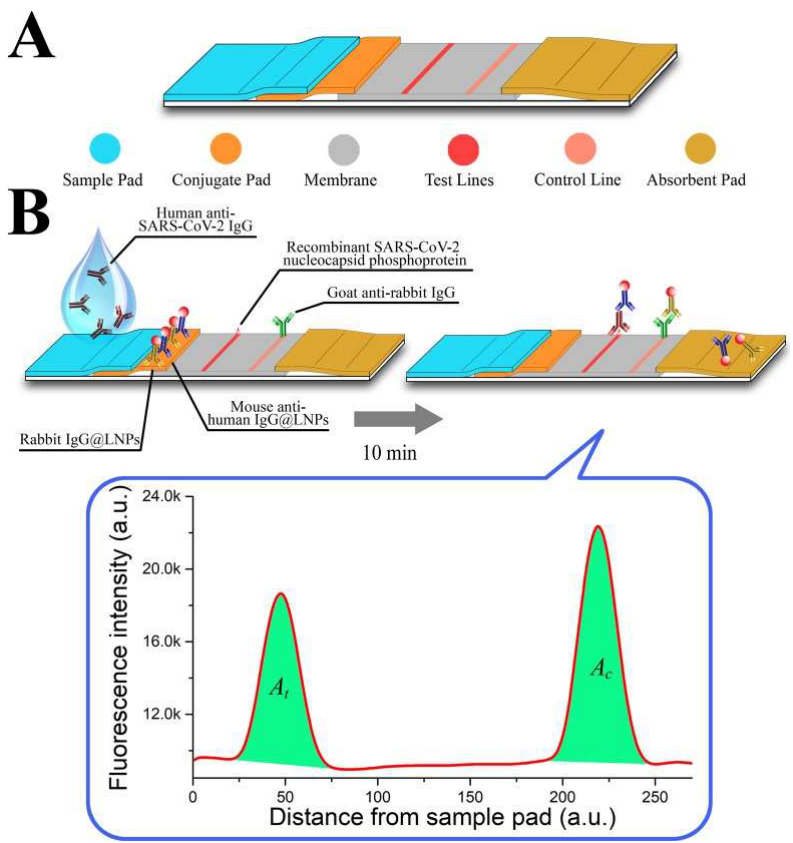
Figure 5. ( A ) An illustration of the developed lateral flow strip; ( B ) An illustration of the assay, incorporating the LNPs as fluorescent signalers [92]. Immunoassays revolving around AuNPs were also developed for the detection of SARS-CoV-2. Wen et al. [71] described the creation of a point-of-care LFIA used to detect the IgG antibodies against SARS-CoV-2. The strip was compromised of an immobilized SARS-CoV-2 nucleocapsid protein on the strip’s surface and anti-human IgG coupled with colloidal AuNPs. Colloidal AuNPs were mainly chosen for this sensor due to their stability, ability to provide interpretable results with the naked eye and excellent biocom- patibility [71]. The detection mechanism is based on antigen-antibody interactions, where the presence of IgG antibodies of SARS-CoV-2 would form a complex with the anti-hu- man-antibody-AuNP compound and subsequently migrate to the bound nucleocapsid protein (test line). Thereby, a positive result would be indicated based on whether there